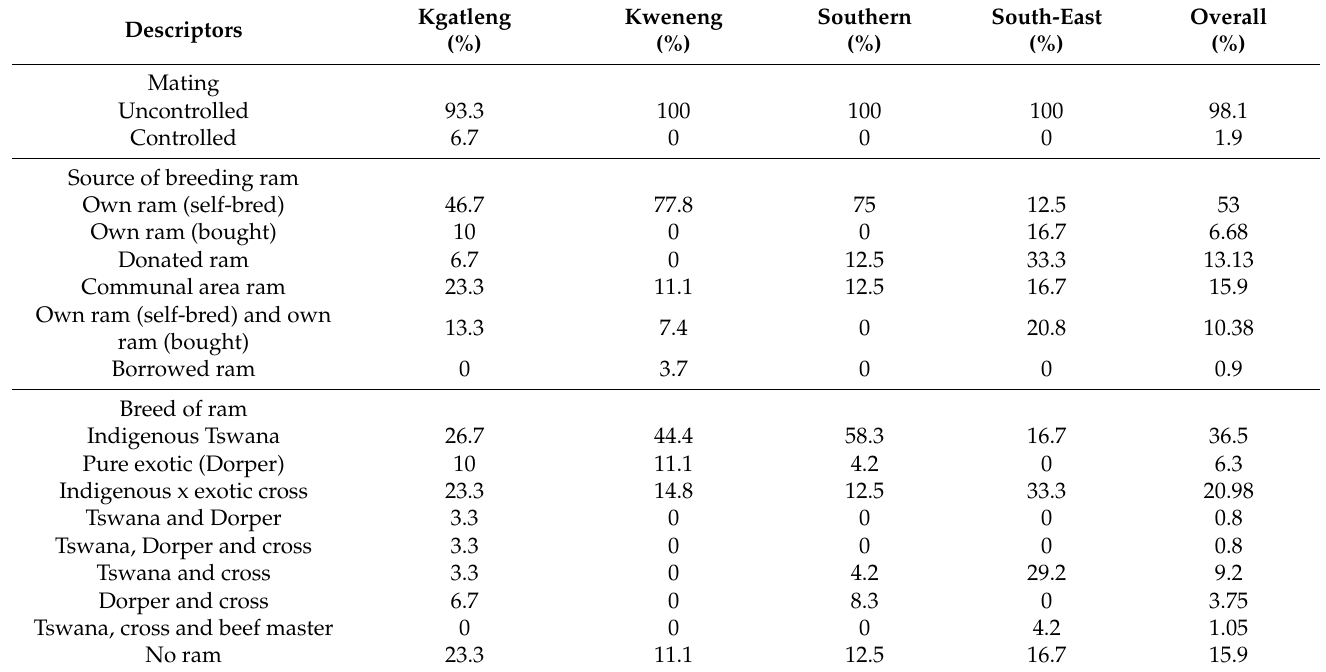
Table 4. Frequency of mating systems, source and breeds of breeding rams in the four surveyed